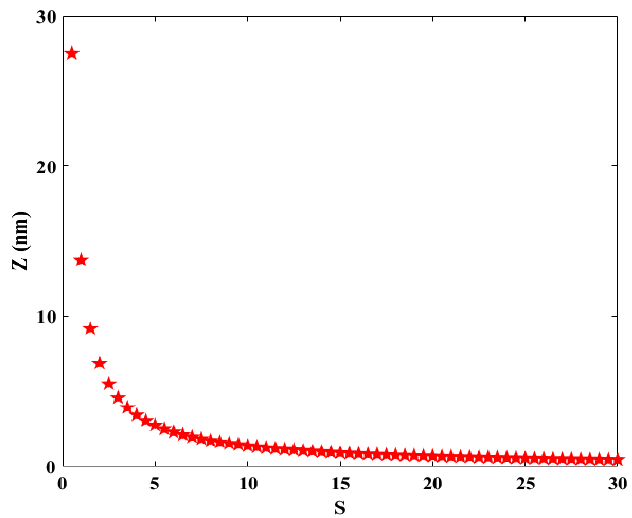
Figure 3. Z versus S in twisted graphene.